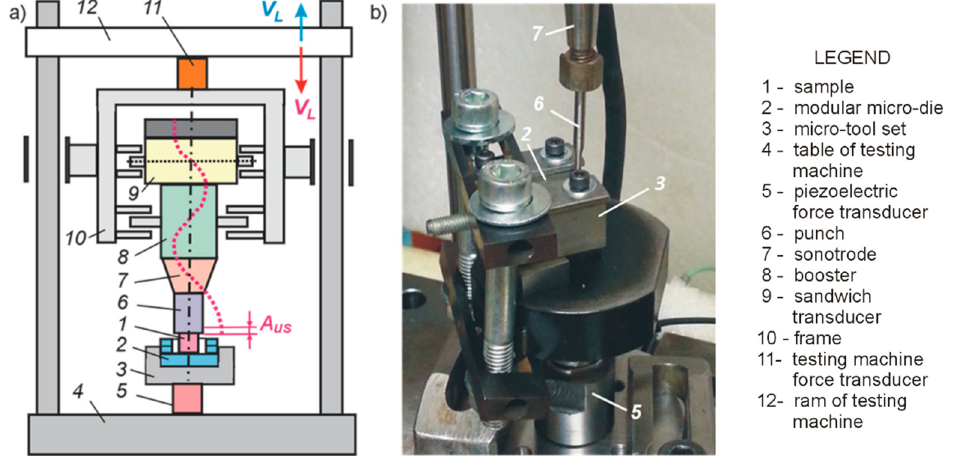
Figure 1. Experimental stand: ( a ) scheme of the test stand, and ( b ) close-up of working area. The sample 1 is placed in the modular micro-die (2) in the Micro-tool set (3) standing on the force transducer (5) fixed on the table (4) of the testing machine. The sample is deformed using the punch